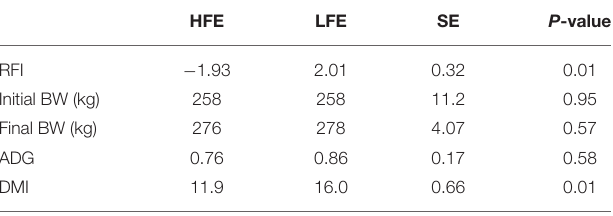
TABLE 1 | Performance of beef steers with divergent residual feed